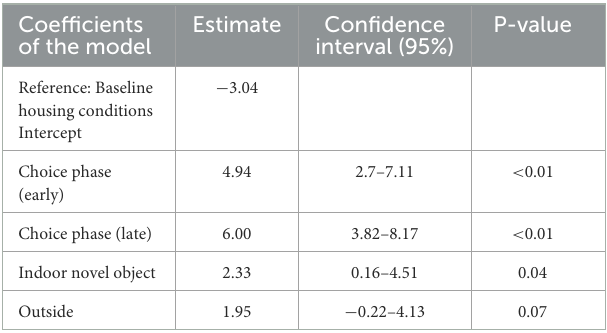
TABLE 2 Group 1: Results of the linear model assessing PC1 and PC2 scores attained during the different treatment